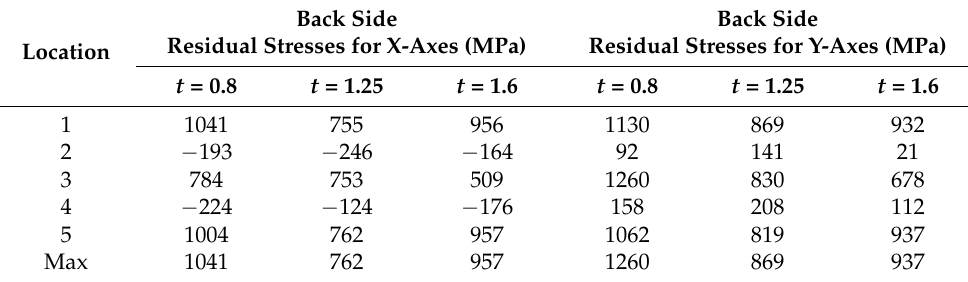
Table 3. Residual stresses for the X and Y axes of the LITECOR ® back side.